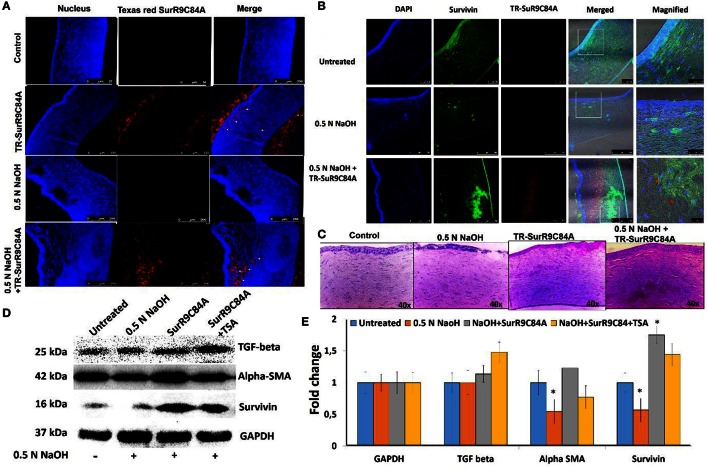
Internalization efficacy of SurR9-C84A in rabbit eye. (A) The Texas-red-SurR9C84A was topically applied on the rabbit cornea and incubated for 10 min before washing with PBS. After another incubation of 30 min, the rabbits were humanely killed following the guidelines of AECG and organs were extracted. The images clearly show presence of Texas-red-SurR9C84A in cornea within 40 min of incubation period. (B) The Texas red labeled SurR9-C84A was able to bind with wild type (WT) survivin (green) in both cornea as well as in retina, WT survivin expression was found to be lowered with NaOH treatment while recurrence of WT survivin was observed with treatments of SurR9-C84A in the rabbit cornea. (C) H & E images revealed localization of Texas red SurR9-C84A in damaged regions of cornea. (D) Western blotting was performed to detect role of important markers involved in wound healing and cell transformation. The corneal lysates were collected and studied for the expression of α-SMA, TGF-β and the house keeping GAPDH along with endogenous WT survivin. (E) Graph representing the densitometric analysis of the western blots showing variations in the fold change of proteins. Data represents mean ± SEM. Experiments were repeated 3 times in triplicates. Representative images have been presented. *P < 0.05.